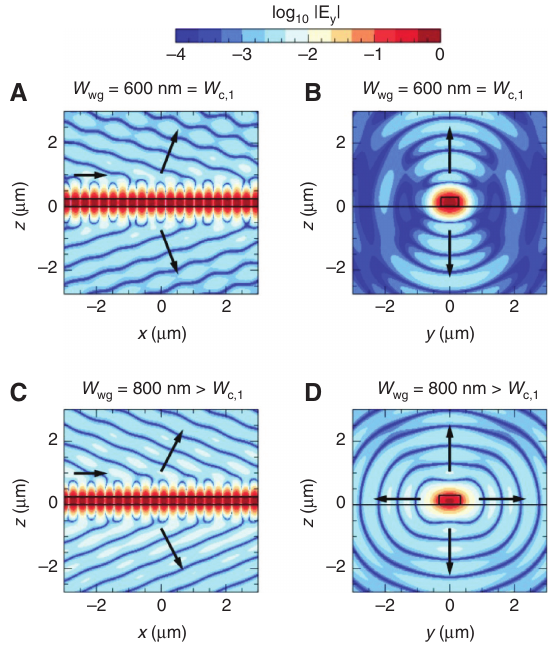
| field) for y = 600 nm = w and (C and D) wg c,1 > w , the light wg c,1